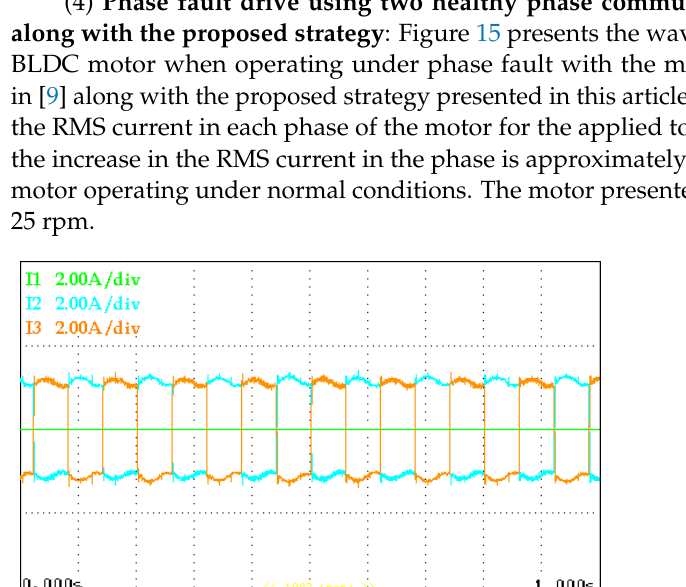
Figure 15. Currents in the BLDC motor operating under phase fault condition with proposed flexibilization on reduction current strategy.